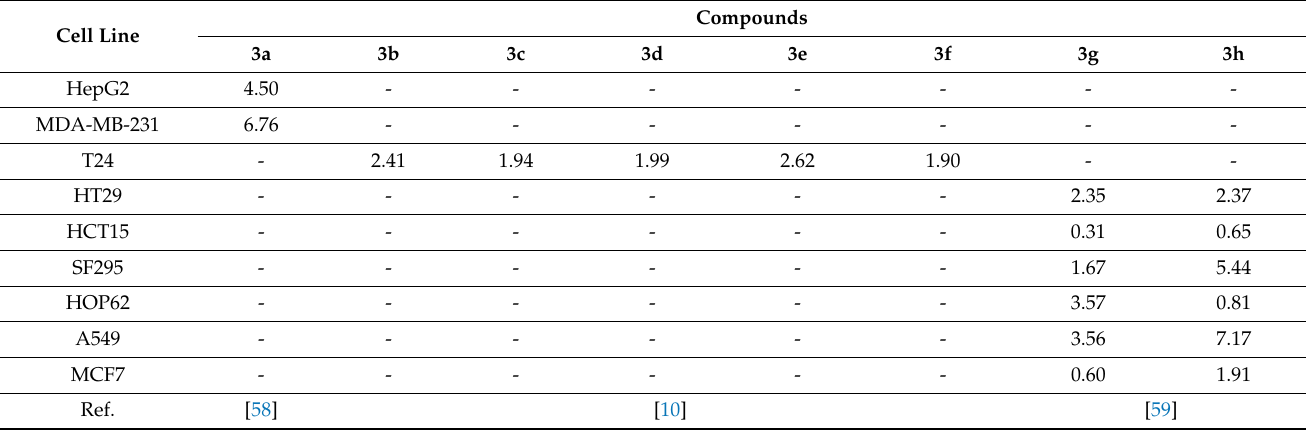
Table 3. IC 50 values ( µ M) of the synthesized pregnane oxime